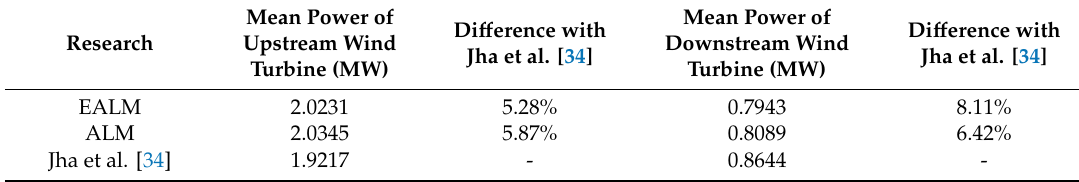
Table 11. Comparisons of mean output power with Jha et al.